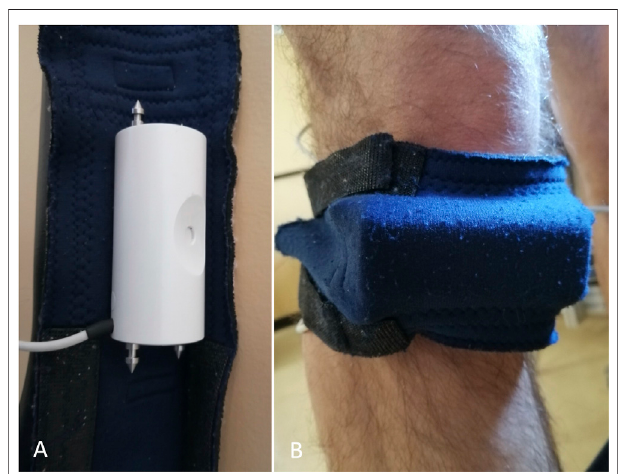
FIGURE 2 | A vibrator used to apply vibrations to the muscle groups of thelowerlimbs (A) ;avibratorheldinplaceonovertheextensormusclesofthe knee, using a neoprene band tightened with Velcro (B)